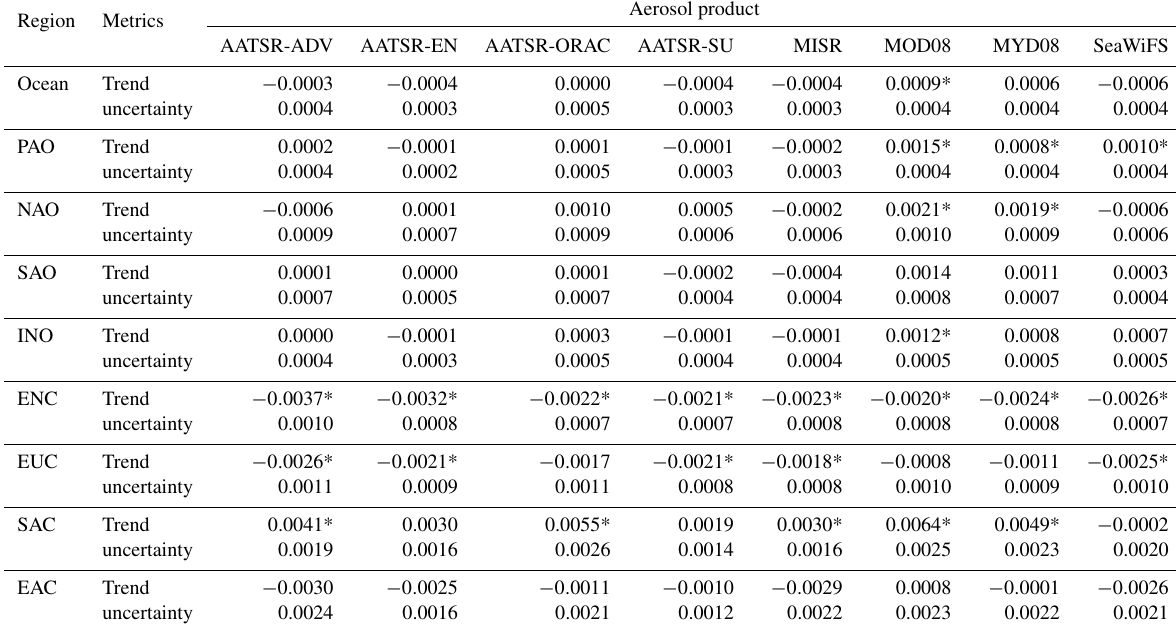
Table 5. Same as Table 4 but for